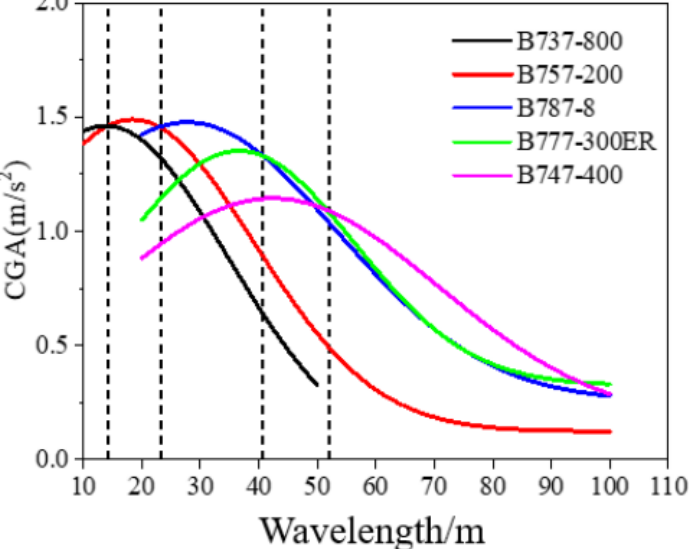
Figure 10. Maximum value of CGA versus different wavelength bumps for five aircraft model types.